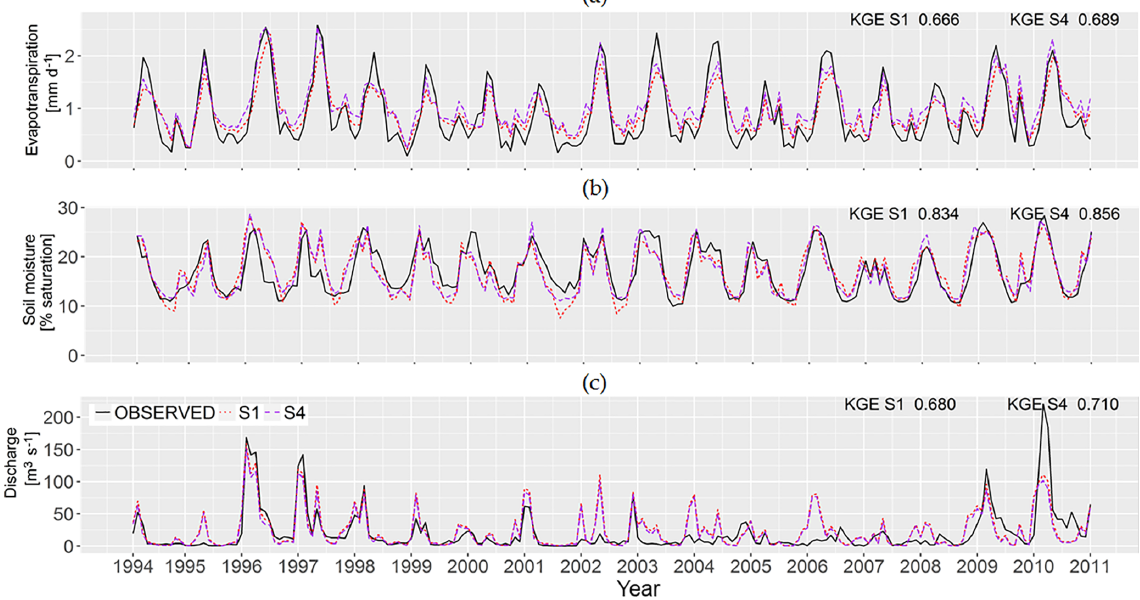
Figure 8. (a) Monthly GLEAM actual evapotranspiration (black) and estimated actual evapotranspiration (red and purple) time series over the entire Oum er Rbia basin. (b) Monthly ESA CCI soil moisture (black) and estimated soil moisture (red and purple) time series over the entire Oum er Rbia basin. (c) Monthly observed discharge (black) and estimated discharge (red and purple) time series at Mechra Eddahk. The red dashed lines represent estimates from calibration scenario S1. The purple dashed lines represent the calibrated time series from calibration scenario S4 which are taken from the runs that yield the best simulations. Estimated time series over the entire Oum er Rbia basin for the validation time period obtained with MSWEP precipitation are